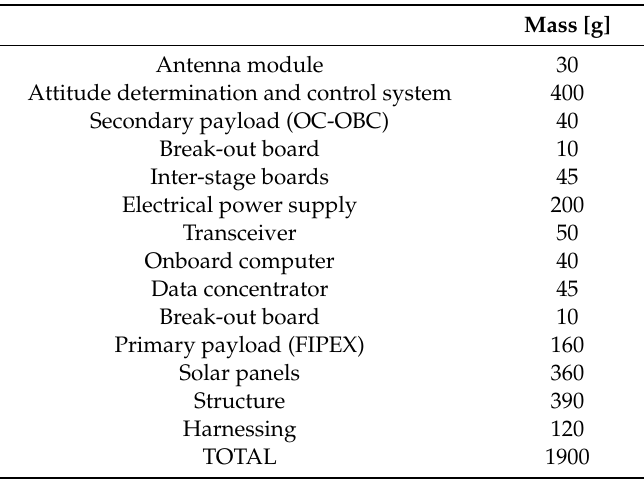
Table 1. SE01’s mass Table 1. SE01 ′ s mass budget.